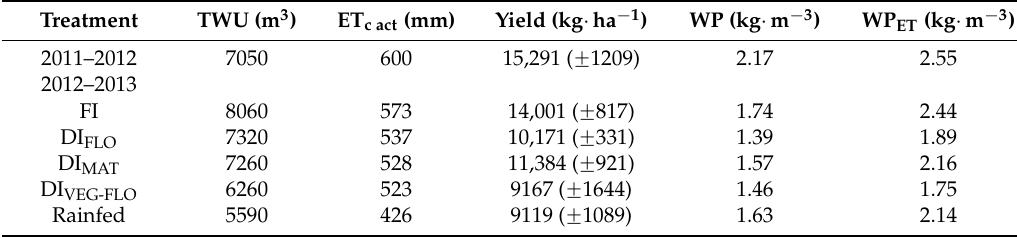
Table 8. Observed total water use (TWU), yield and water productivity.